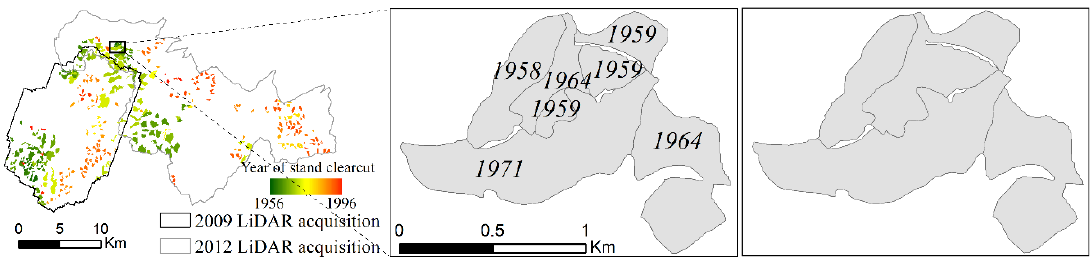
Figure 2. Example of pre-processing of the FACTs harvest polygons. Adjacent polygons harvested within a time interval ≤ 5 years (left) are merged into aggregated polygons (right) that are used as reference objects in all the subsequent steps of the analysis.